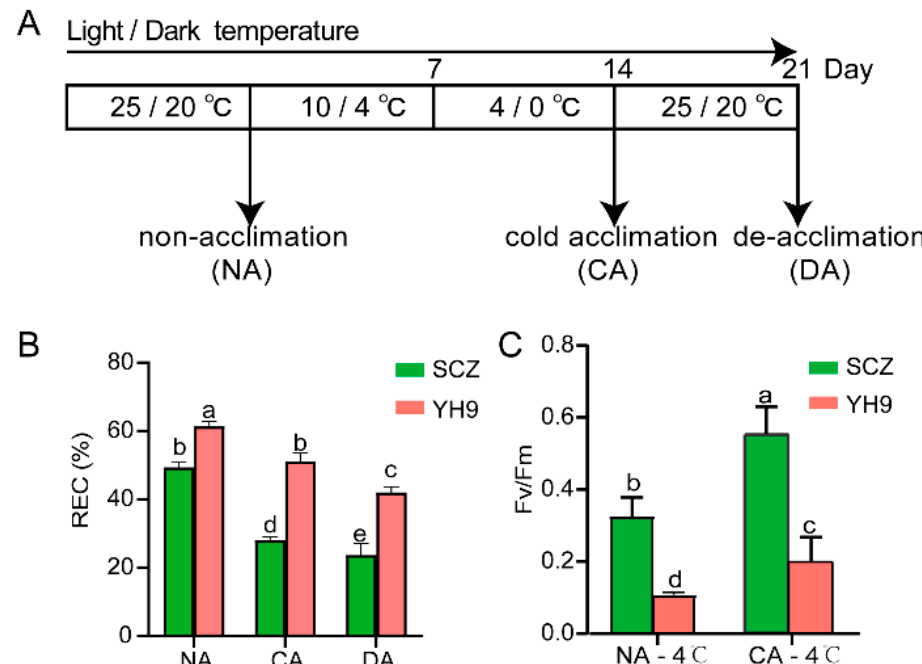
Figure 1. Cold resistance analysis of SCZ and YH9 under cold acclimation. ( A ) Temperature setting and sampling time points during cold acclimation. NA indicate the sampling time points of the control plants; CA, the sampling time points of the respective cold acclimation plants; DA, the sampling time point of de-acclimation plants after a seven-day lag phase at CA. ( B ) The relative electrical conductivity of SCZ and YH9 at NA, CA, and DA stages. ( C ) Statistical analysis of the photochemical efficiency of photosystem II (Fv/Fm) of SCZ and YH9 tissue culture seedlings subjected to freezing ( − 4 ◦ C, 12 h) at NA and CA stages to assess their cold stress resistance. Error bars indicate the mean ± SD of 16 biological repeats. The different lowercase letters above bars indicate the significance ( p < 0.05).